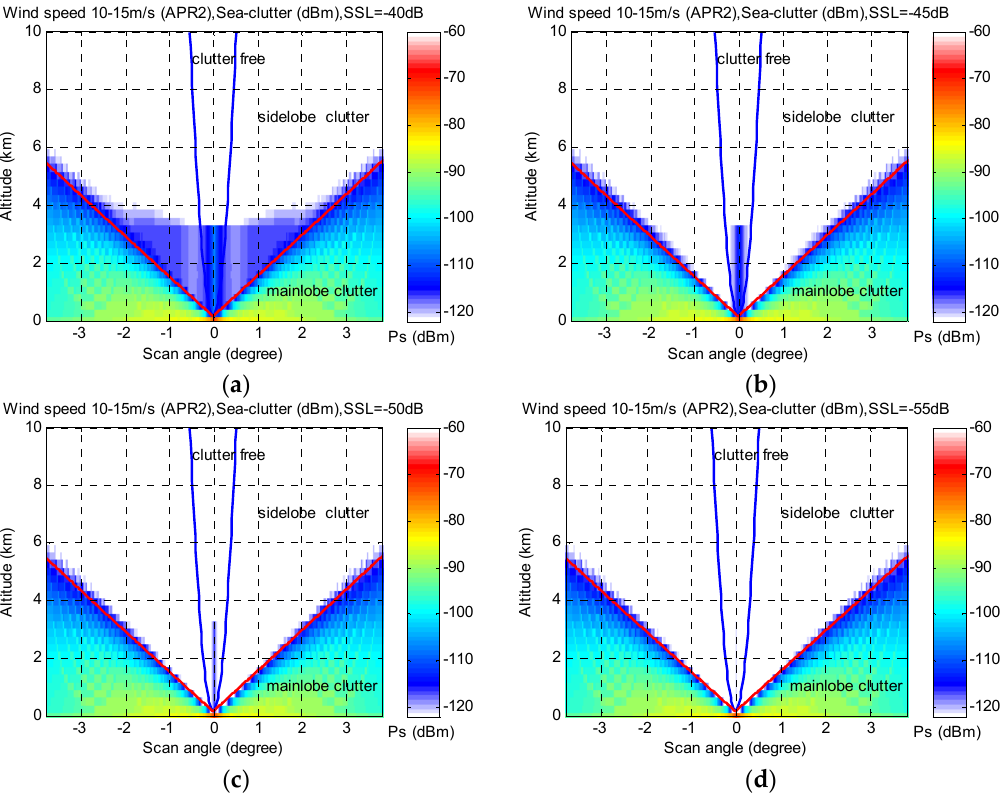
Figure 11. Power distribution (dBm) of sea clutter under different range sidelobes, where wind speed is 10–15 m/s. The data of NRCS is measured by APR2. ( a ) range sidelobe: SSL = − 40 dB; ( b ) range sidelobe: SSL = − 45 dB; ( c ) range sidelobe: SSL = − 50 dB; and ( d ) range sidelobe: SSL = − 55 dB.